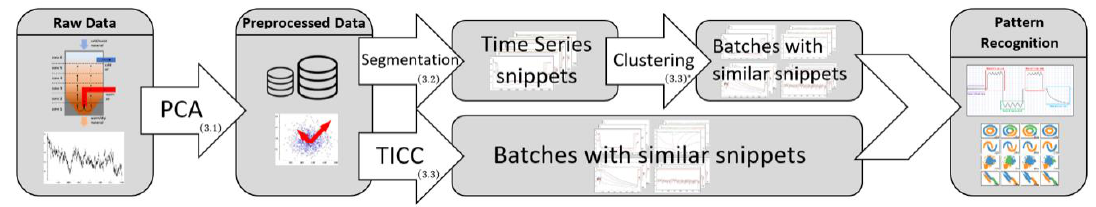
Figure 4. Overview of proposed time series processing framework.